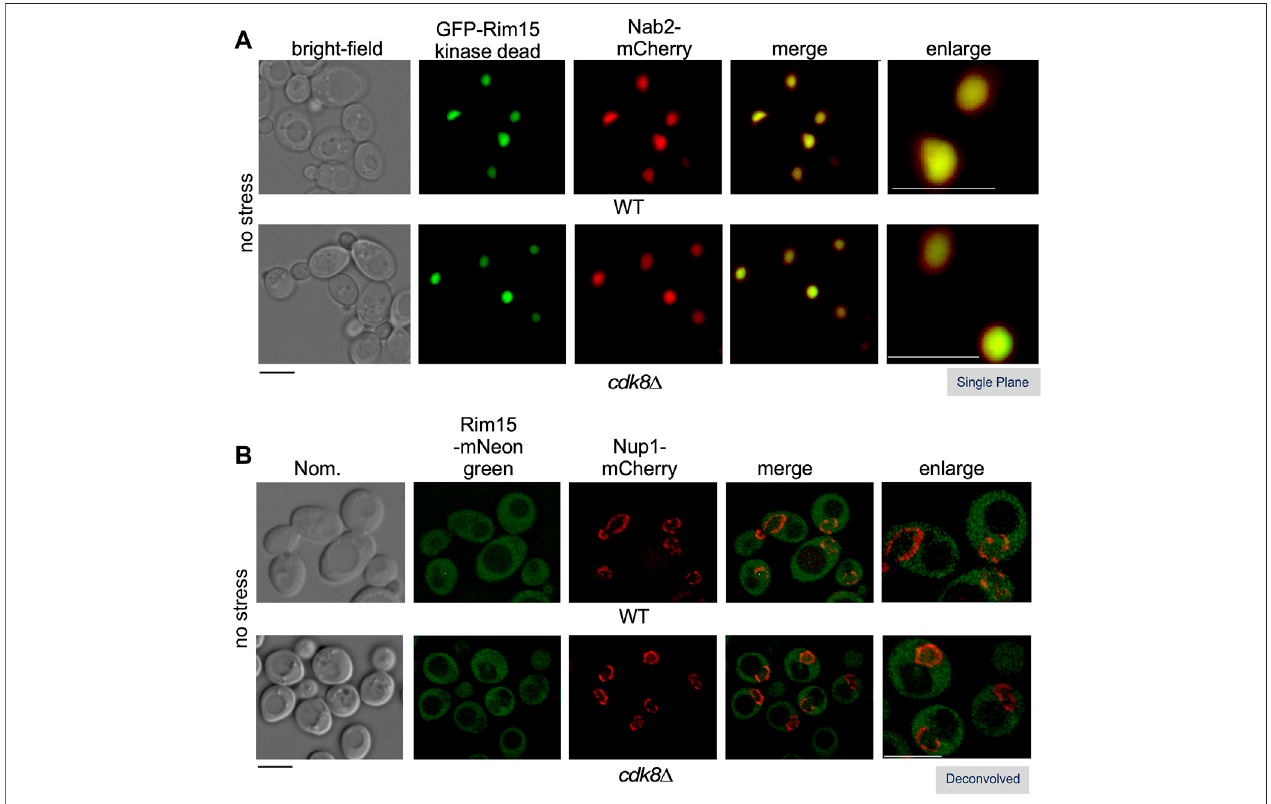
FIGURE 5 | Cdk8 does not alter Rim15 nuclear shuttling. Localization of Rim15 in wild type and cdk8 Δ cells. (A) The nuclear localization of kinase dead Rim15 (C1190Y) is not affected in cdk8 Δ cells. Kinase dead GFP-Rim15 (pFD633) and the nuclear marker Nab2-mCherry were examined by fl uorescence microscopy in wild type (RSY10) and cdk8 Δ (RSY2176) cells in replete media. (B) Localization of endogenous Rim15-mNeonGreen and Nup1-mCherry in wild type (RSY2375) and cdk8 Δ (RSY2454) in unstressed cells. Representative deconvolved or single-plane images are shown. Scale bar: 5 µm. Nom. — Nomarski imaging.